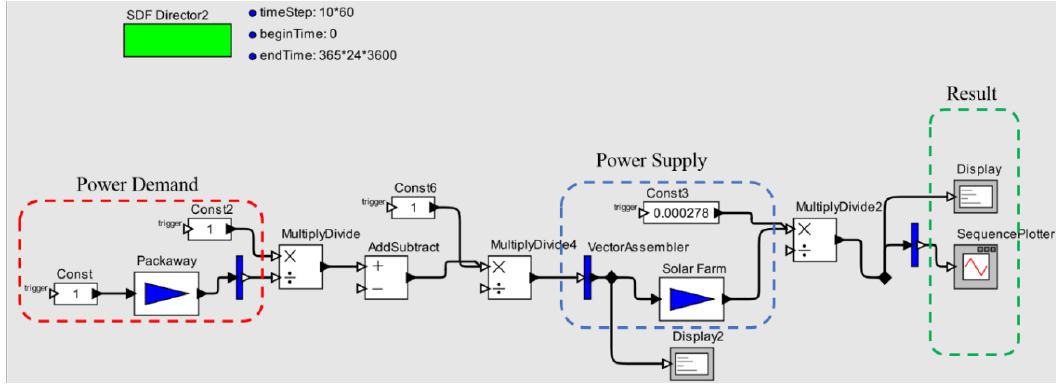
Figure 6. Integrating power supply and demand in BCVTB.